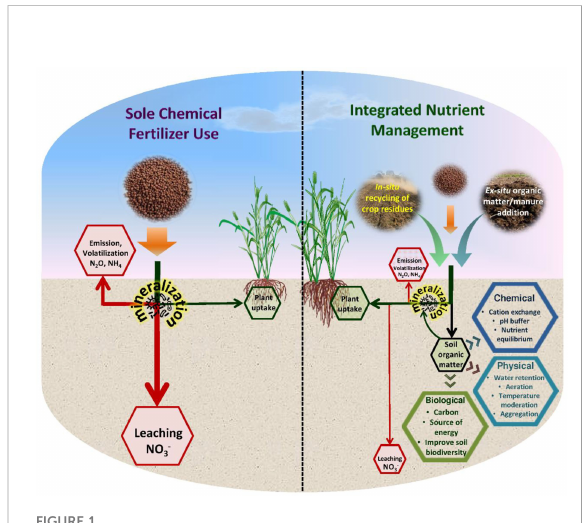
FIGURE 1 Contrasting in fl uences of sole chemical fertilizer vs. integrated nutrient management on the nitrogen pools, mineralization, leaching, and volatilization fl